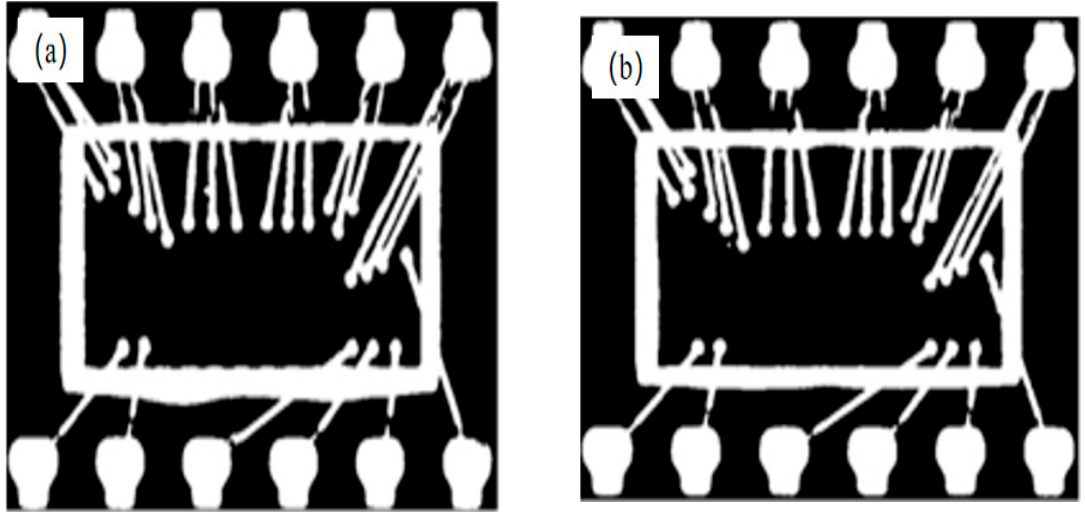
Figure 6. Binary image of pin side. ( a ) Unevenly and ( b ) evenly distributed epoxy resin.